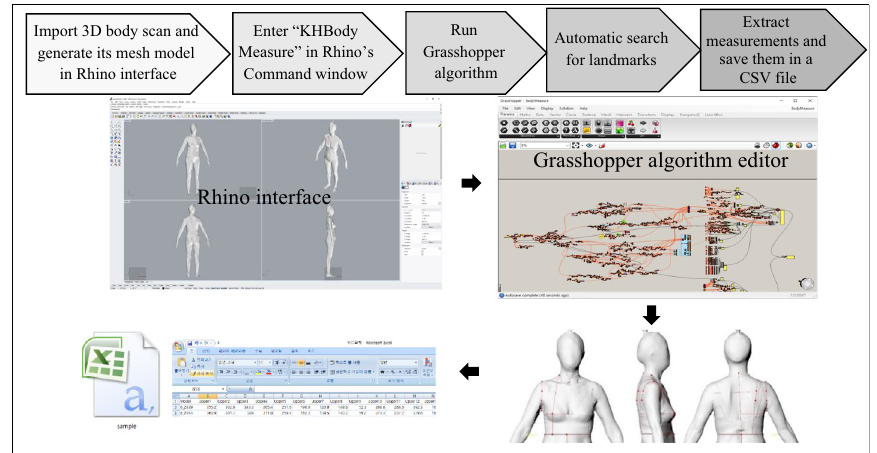
Fig. 1 Process for automatic search for upper body landmarks and extraction of